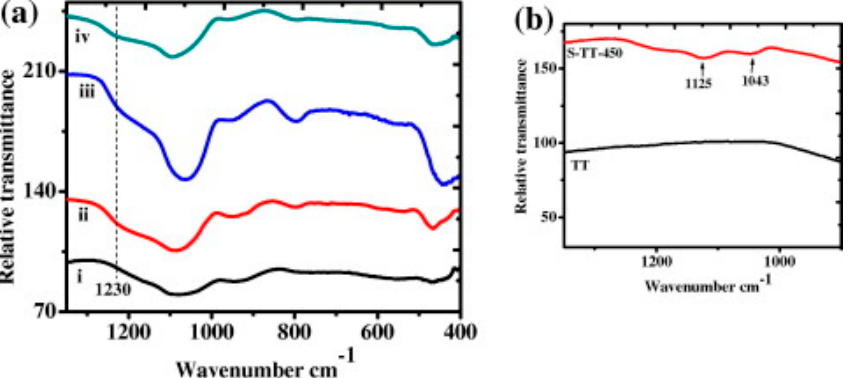
Figure 8. FT-IR spectra of the pure and sulfated titania–silica catalysts ( a ) titania–silica composite (TSC) (i), sulfated titania–silica composite (S-TSC) (ii), S-TSC-450 (iii), S-TSC-550 (iv). ( b ) The FT-IR spectra of pure and calcined sulfated titania (Copyright of Elsevier, see